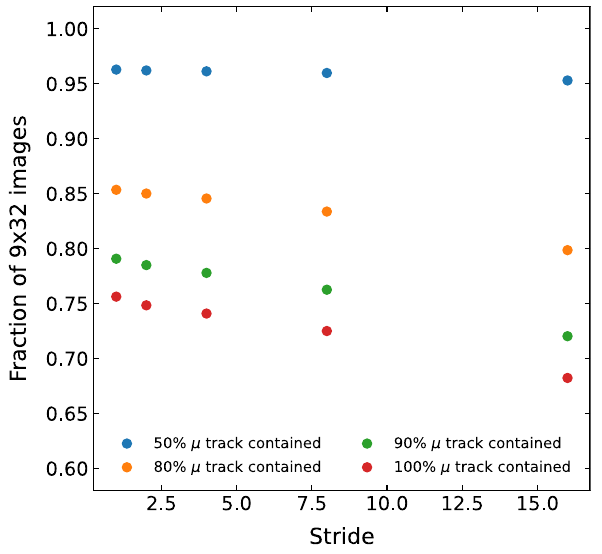
Fig. 3 Stride comparison. When splitting the original 9 × 384 image into smaller 9 × 32 ones with fixed stride, inevitably part of the muon track gets lost. The blue, yellow, green and red points represent the fraction of 9 × 32 images which include respectively the 50, 80, 90 and 100% of the muon track